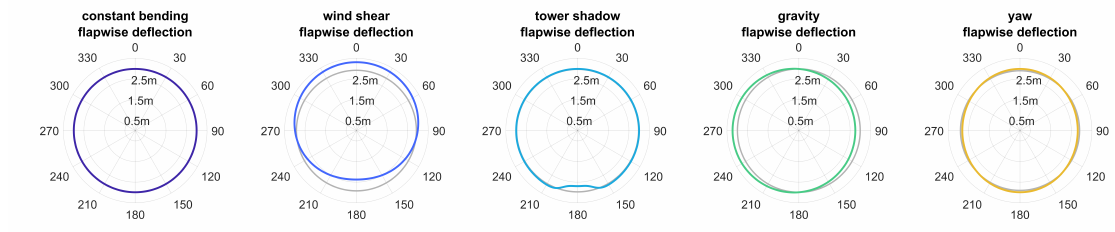
Figure 11. Flapwise deflection for simulated bending under bending effects at a mounting position of R = 55m on a 60m blade.